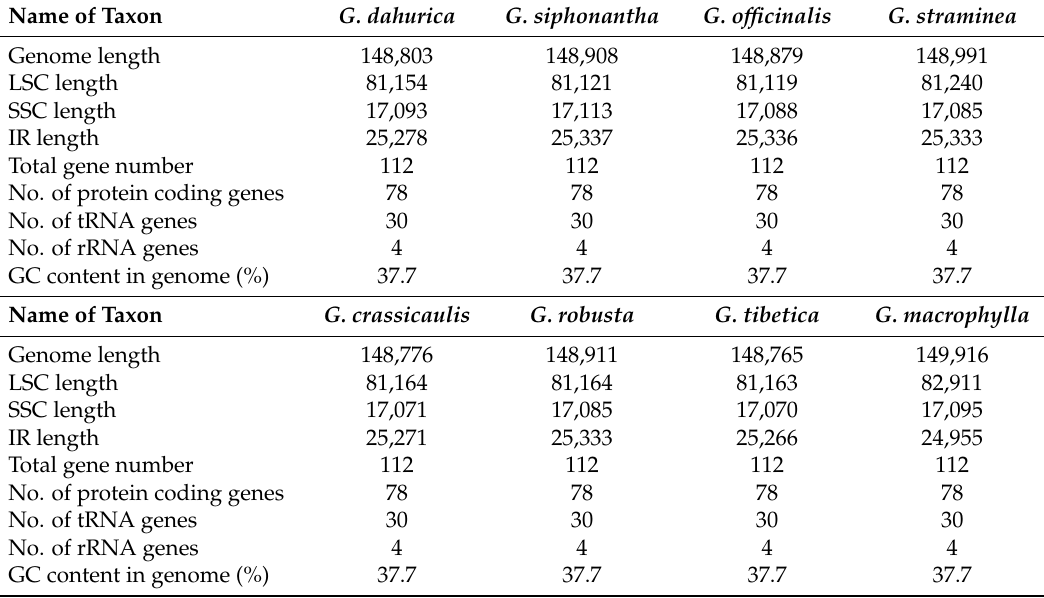
Table 1. Summary of complete chloroplast genomes for eight Gentiana